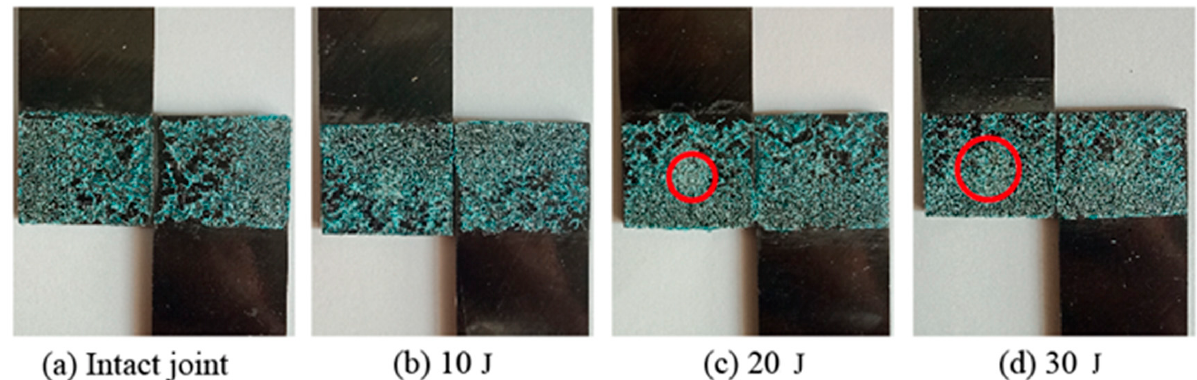
Figure 13. The adhesive film damage of TAI of CFRP laminate SLJs: ( a ) Intact joint, ( b ) 10 J, ( c ) 20 J, ( d ) 30 J.